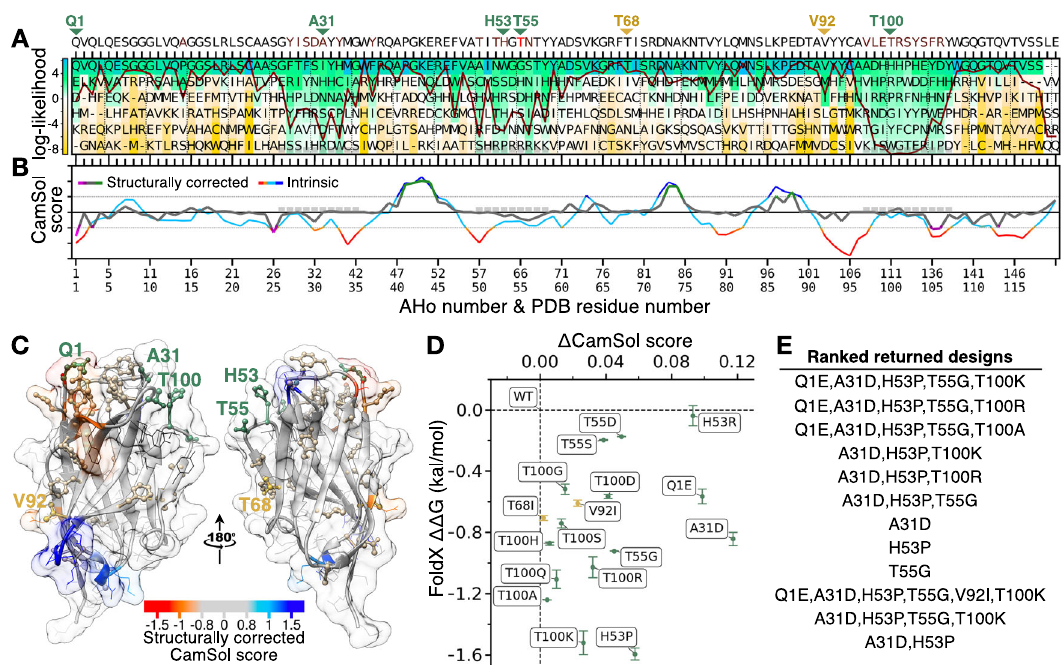
Fig.3|MainpipelinestepsforNb.b201.A RepresentationofthePSSMcalculated fromanalignmentof1396single-domainantibodysequences.Thelog-likelihoodat each position (colour-bar) is used to select candidate amino acid substitutions (allowed log-likelihood > 0). The sequence above the panels is the wild-type Nb.b201, residues in red have log-likelihood <0 (T55). The dark red line is the conservationindex(highmeanspositionmoreconserved).GreyboxesdenoteCDR positions. Green or gold triangles point to mutation sites where at least one can- didate mutation was shortlisted by the single-mutational scanning step (panel D). The last two residues (LE) do not have PSSM information, as they belong to a cloning restriction site. B CamSol pro fi les of Nb.b201. The CamSol intrinsic pro fi le is coloured red toblue, where red meansaggregation-proneand blueaggregation- resistant. It is common for globular proteins to have large aggregation-prone regionsintheirintrinsicpro fi lethatdrivethehydrophobiccollapseduringfolding.